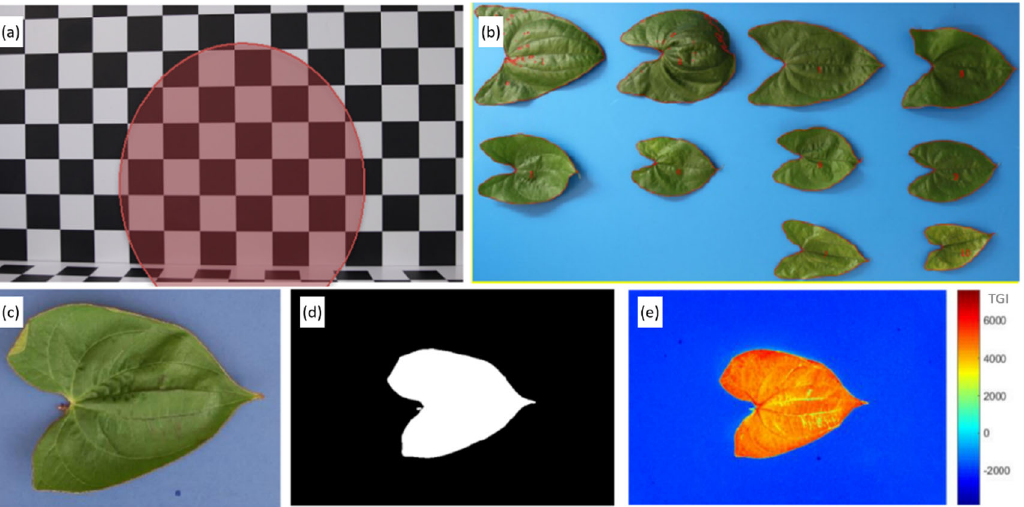
Figure 2. ( a ) Checkerboard for distortion correction; ( b ) leaves spread out on the blue plate; ( c ) single leaf; ( d ) segmented leaf; and ( e ) single leaf triangular greenness index, TGI. Red dots on leaves ( b ) indicate saturated pixels or necrotic tissue not identified as green and excluded from the spectral index analysis.